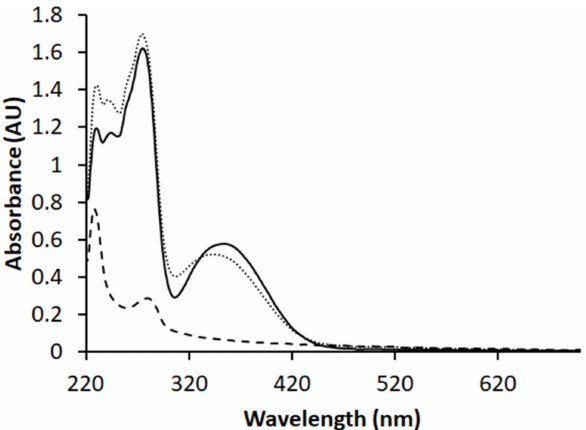
Figure 5. Absorption spectra of ILDF microparticles after dissolving in 70% ethanol (short dash) solution, displayed with that of 50 µ M Flavopiridol in 70% ethanol (solid black line). The spectrum of the same microparticles without Flavopiridol, i.e., ILD microparticles, serves as blank or negative control and is plotted in the same coordinate (long dash) as a